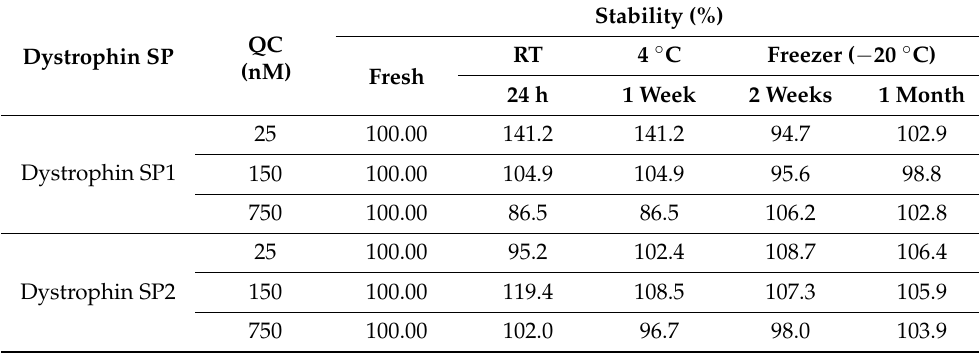
Table 4. Dystrophin signature peptide solution stability at different storage conditions for a deter- mined period.